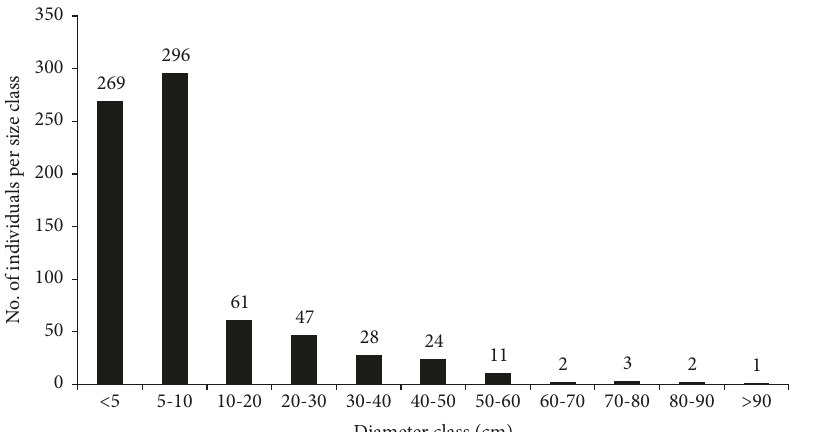
Figure 7: Size class distribution of individual woody species of DBH ≥ 5cm identified in the self-regenerated secondary forest in Ruhande Arboretum, Huye,